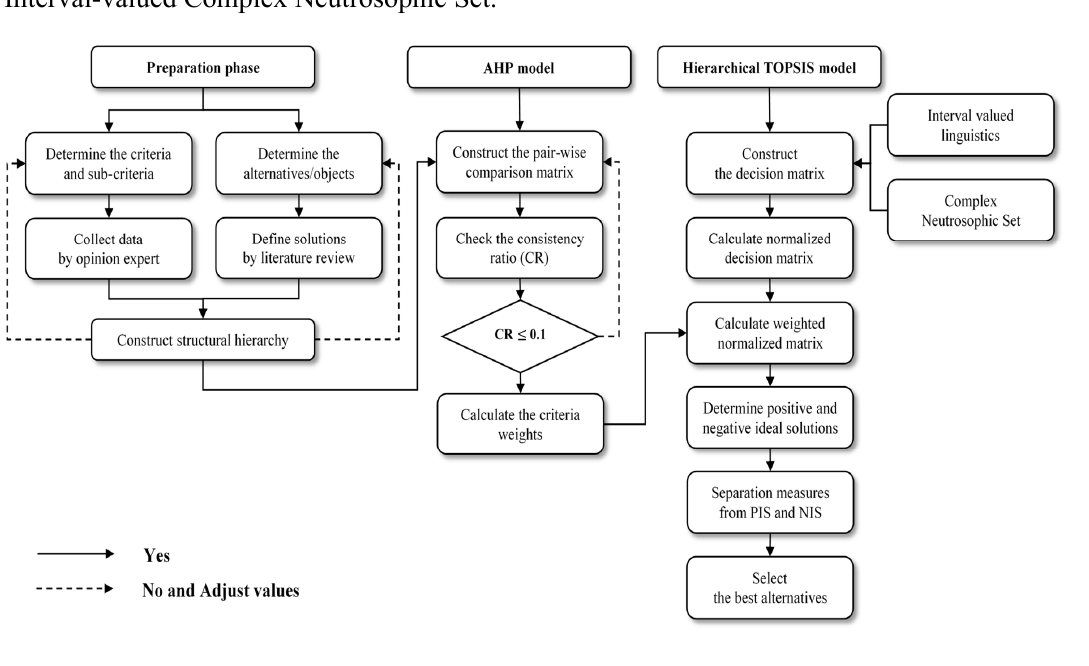
Fig 2. The methodology